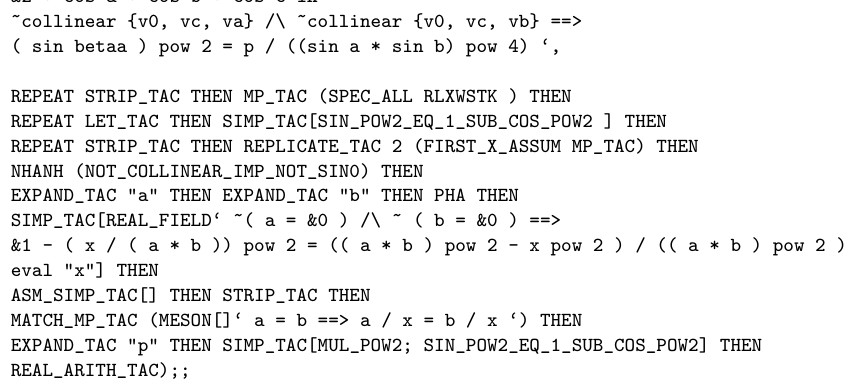
Fig. 2. An extract from a typical Flyspeck proof script, trigonometry/trig2.hl .